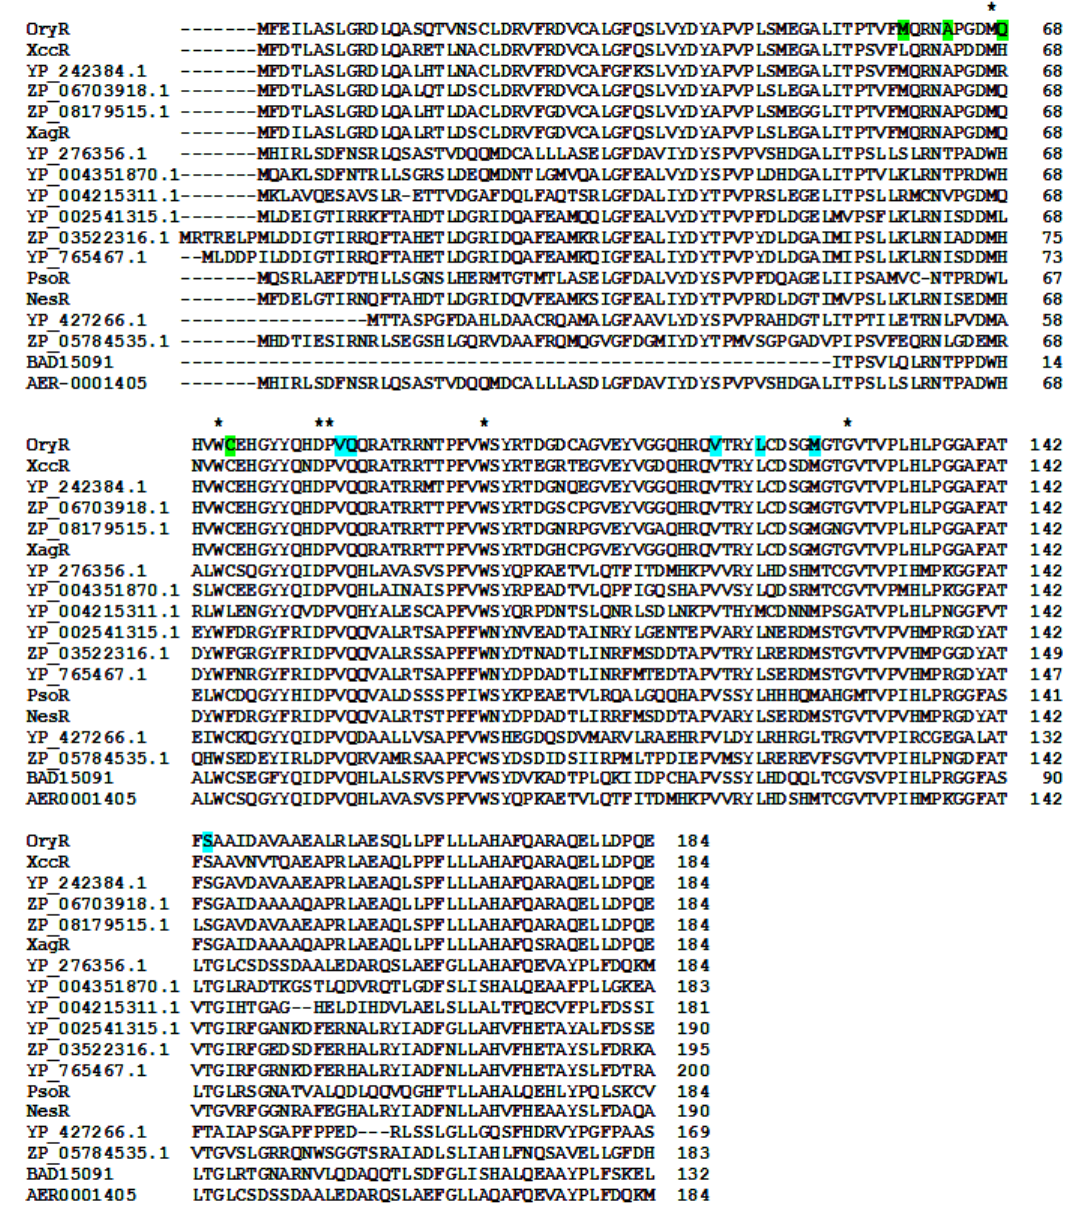
Figure 4. Multiple sequence alignment of the PAB LuxR solos subfamily members. The residues of the PAB LuxR solos subfamily homologous to Cluster 1 are highlighted by a star while the ones homologous to Cluster 2 and Cluster 3 (see text) are highlighted in cyan and in green,